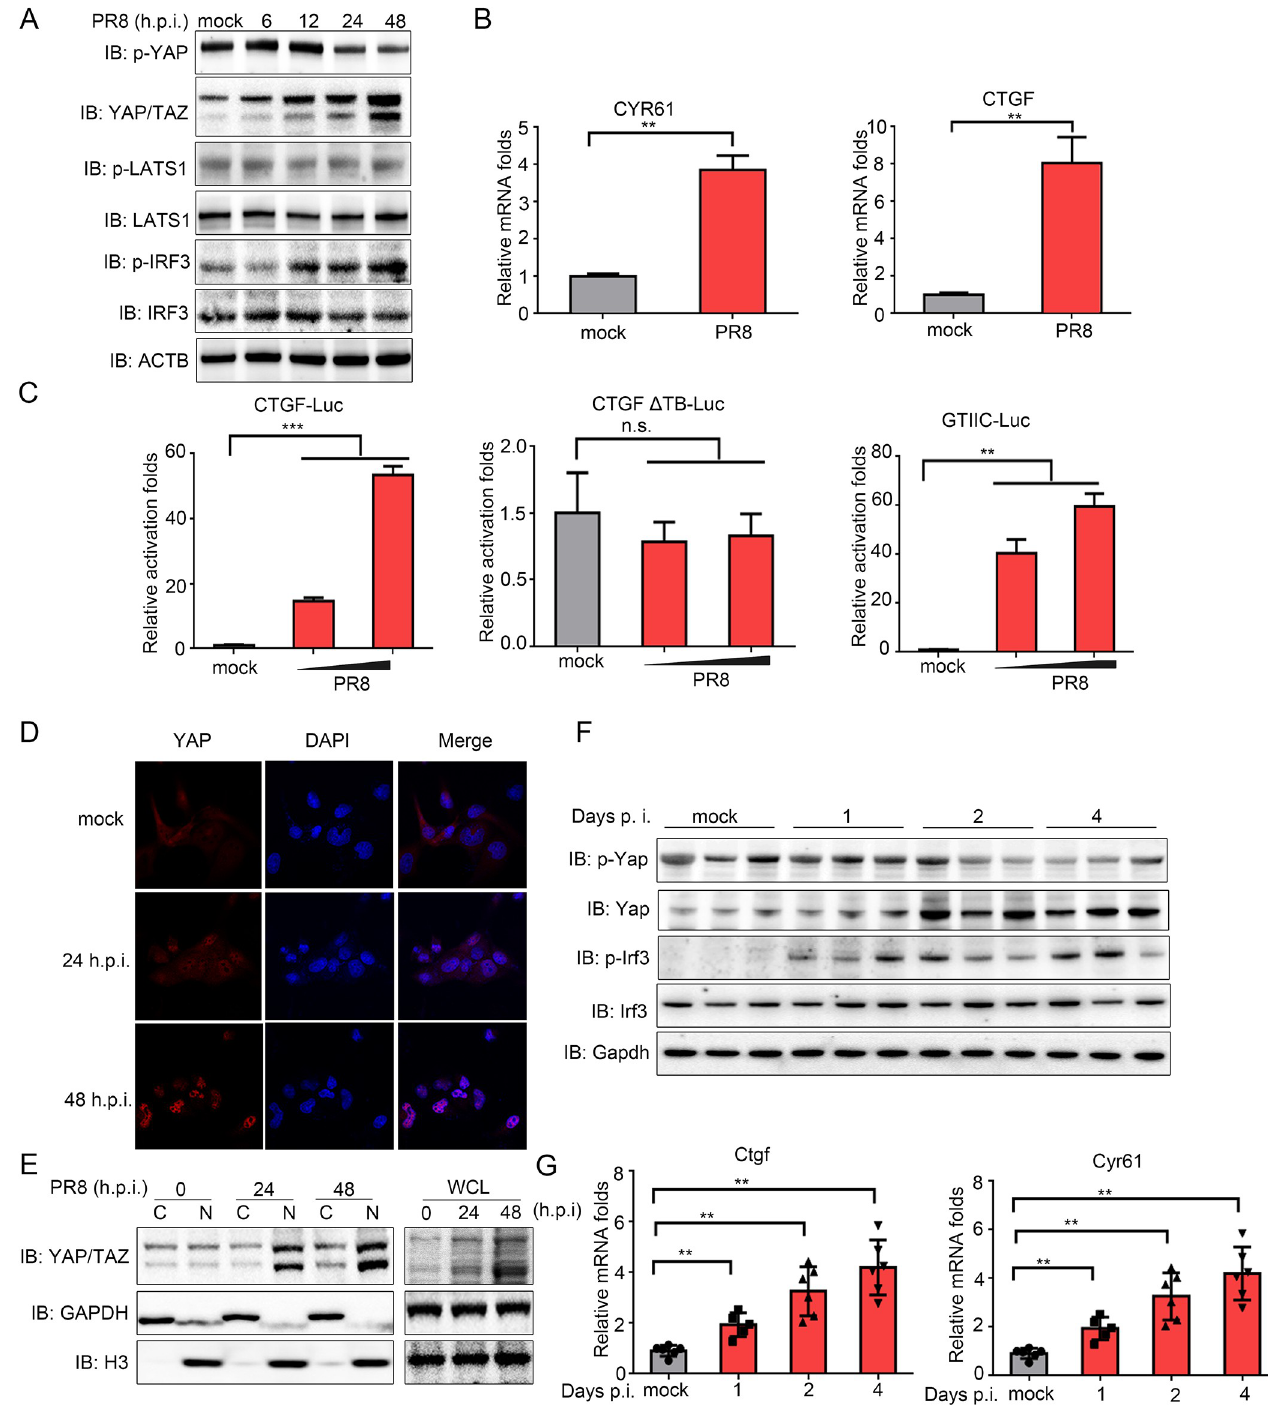
Fig 1. IAV infection potentiates the activity of YAP/TAZ. (A) A549 cells were infected with PR8 or mock virus at an MOI of 0.01 for 6, 12, 24 and 48 hours. Cells were then lysed and analyzed by SDS-PAGE. Immunoblotting was conducted with indicated specific antibodies. (B) A549 cells were infected with PR8 or mock virus at an MOI of 0.01 for 12 hours. Cells were then lysed and mRNA expression of CYR61 and CTGF was determined using RT-qPCR. (C) A549 cells were transfected with CTGF-Luc, CTGF Δ TB-Luc and GTIIC-Luc, along with Renilla luciferase control. At 12 hours post transfection, cells were either mock infected, or infected with 0.005 or 0.01 MOI of PR8 virus for another 12 hours, at which time point the promoter activities were measured using a dual- luciferase assay. (D) A549 cells were infected with PR8 or mock infected. Cells were fixed at 24 or 48 hours post infection and stained with anti-YAP antibody and DAPI for immunofluorescence microscopy. (E) Cytosolic (C) and nuclear (N) fractions and whole cell lysate (WCL) prepared from PR8-infected A549